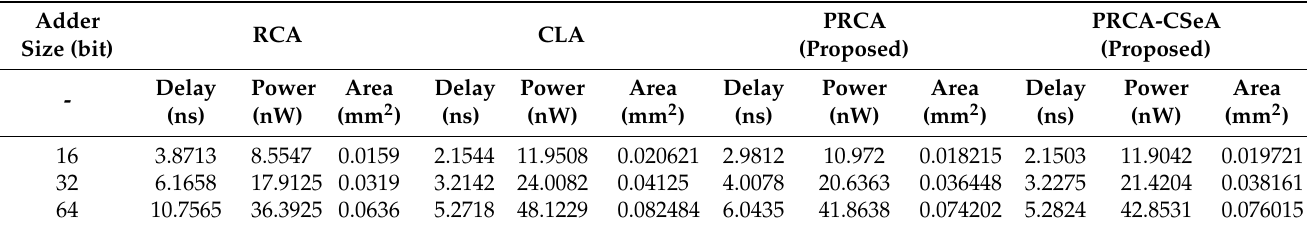
Table 4. Simulation results of delay, power, and area for conventional RCA, CLA, proposed PRCA, and case three of our PRCA-CSeA